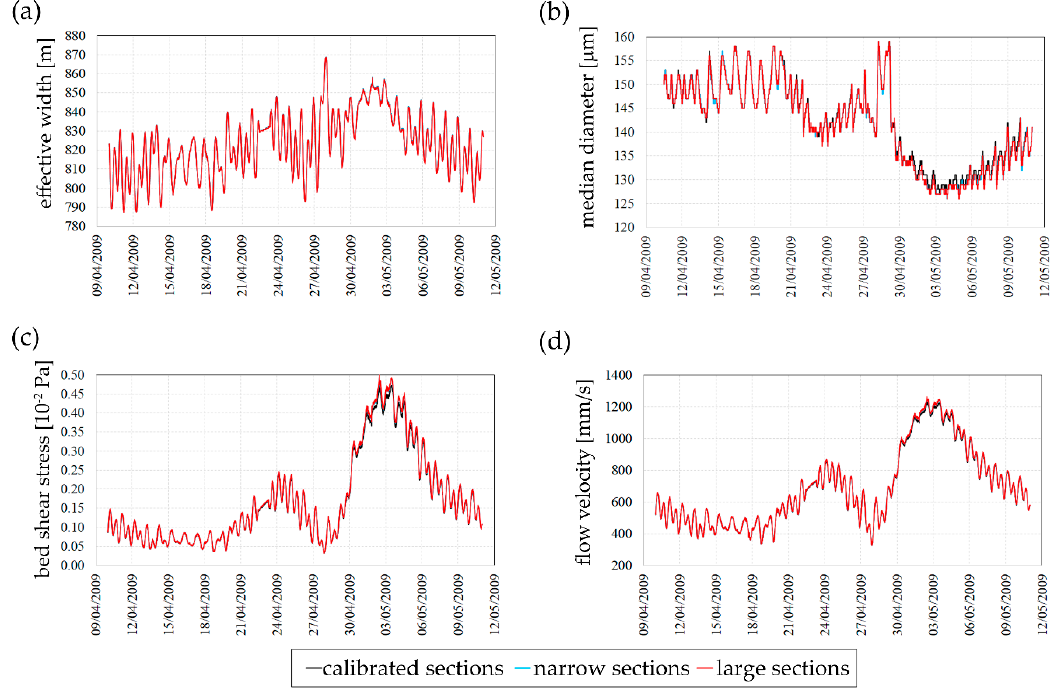
Figure 7. Comparison between calibrated (black line), narrow (blue line) and large (red line) sections at the gauging station of Pila: (a) effective width W ; (b) median diameter d 50 ; (c) bed shear stress τ ; (d) averaged flow velocity v . Geosciences 2020 , 10 , x FOR PEER REVIEW